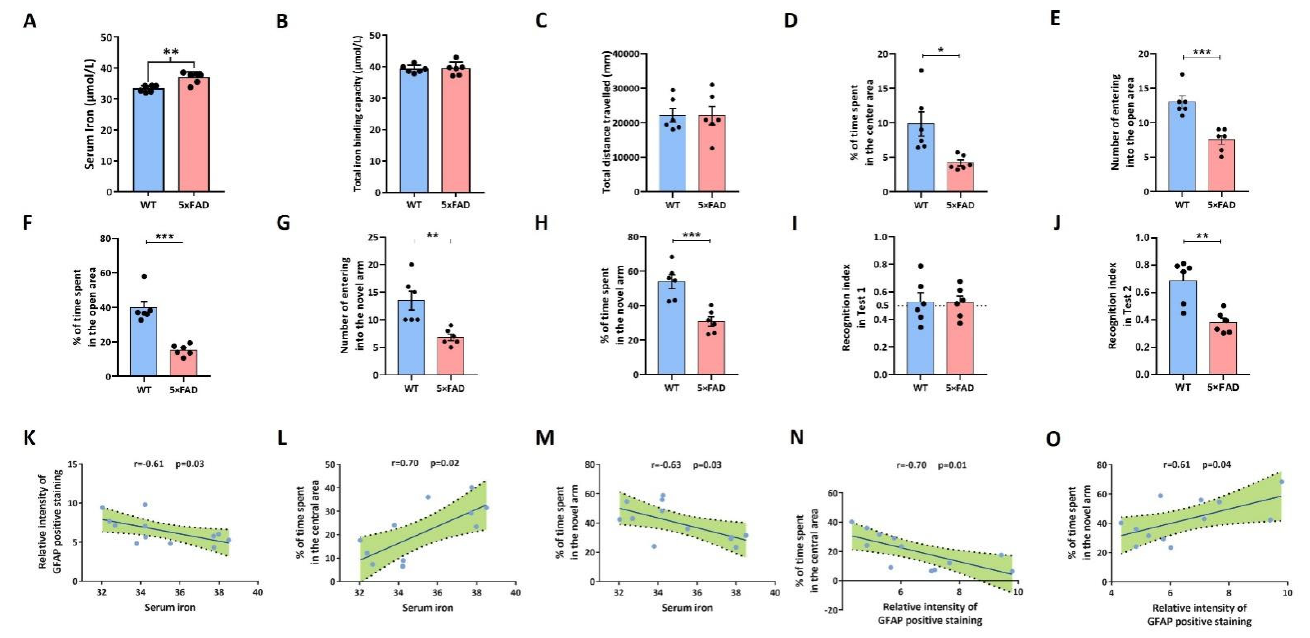
Figure 8. In vivo emotional and cognitive impairment validation. ( A ) Serum iron concentration. ( B ) Total iron binding capacity. ( C ) Total movement distance. ( D ) Percentage of time spent in the central area. ( E ) Number of mice entering open arm in elevated cross test. ( F ) Percentage of time spent entering open arm in elevated cross test. ( G ) Number of mice entering novelty arm in Y-maze test. ( H ) Percentage of time spent entering novelty arm in Y-maze test. ( I ) Percentage of sniffing exercise time between two identical objects in the first stage of novel object recognition. ( J ) Percentage of sniffing exercise time between mice in the second stage of novel object recognition. Black circle rep- resents number of mice. ( K ) Correlation between serum iron concentration and relative intensity of GFAP positive staining, r = − 0.61, p = 0.03. ( L ) Correlation between serum iron concentration and percentage of time spent in the central area, r = 0.70, p = 0.02. ( M ) Correlation between serum iron concentration and percentage of time spent entering novelty arm in Y-maze test, r = − 0.63, p = 0.03. ( N ) Correlation between relative intensity of GFAP positive staining and percentage of time spent in the central area, r = − 0.70, p = 0.01. ( O ) Correlation between relative intensity of GFAP positive staining and percentage of time spent entering novelty arm in Y-maze test, r = 0.61, p = 0.04. WT: wild type. FAD: familial Alzheimer’s disease. * p < 0.05; ** p < 0.01; *** p < 0.001.